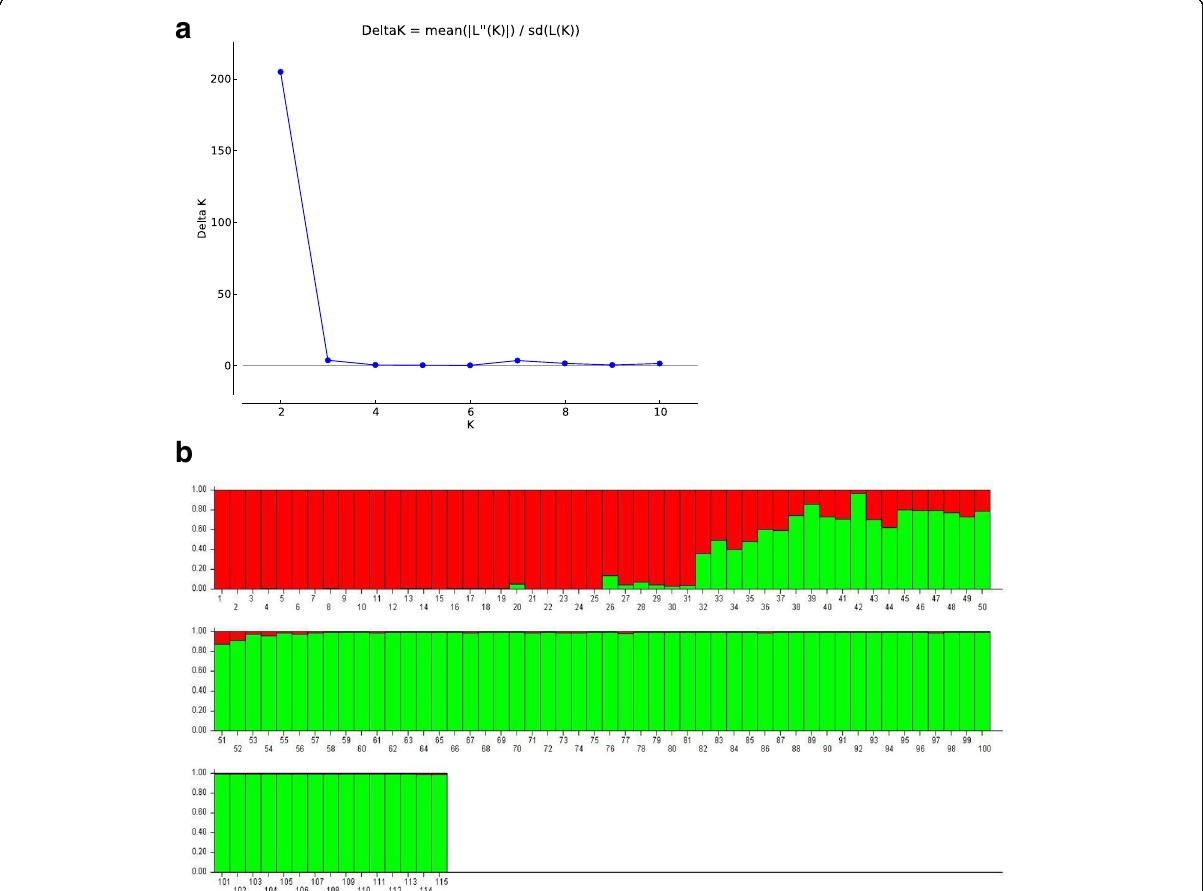
Fig. 8 Structure analysis based on Bayesian clustering of 8 populations (115 accessions); a plot showing the Δ K values; b genetic clustering estimated ( K = 2) showing two genetic